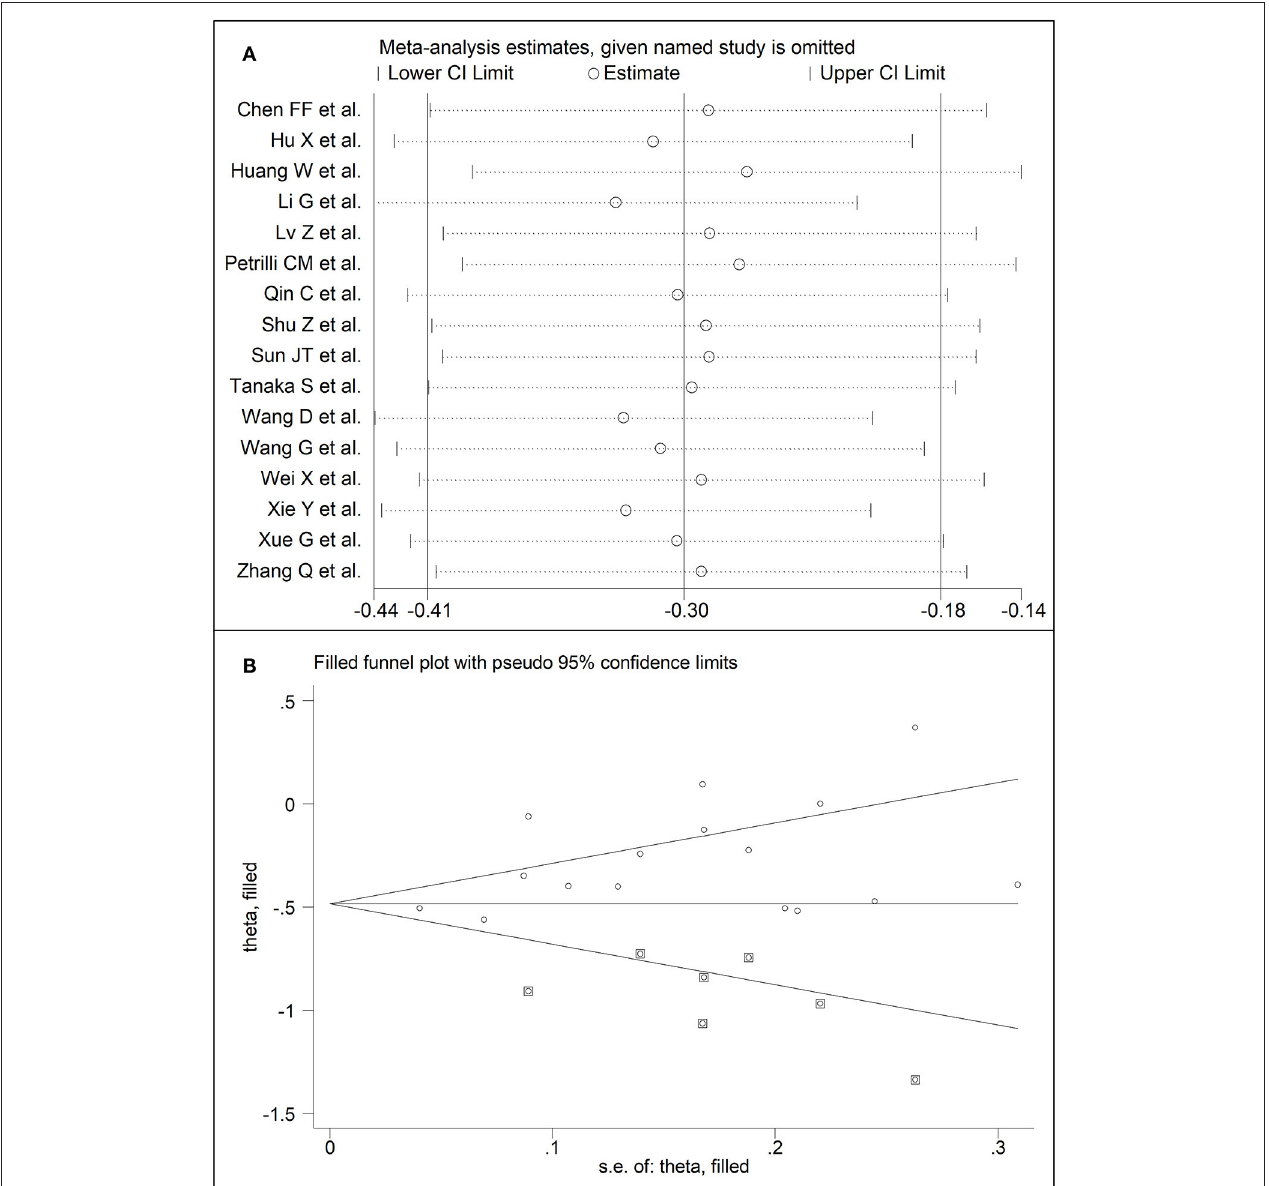
FIGURE 5 | (A) Sensitivity analysis of the association between LDL-cholesterol and COVID-19. The influence of individual studies on the overall standardized mean difference (SMD) is shown. The middle vertical axis indicates the overall SMD and the two vertical axes indicate the 95% confidence intervals (CIs). The hollow circles represent the pooled SMD when the remaining study is omitted from the meta-analysis. The two ends of each broken line represent the 95% CIs. (B) Funnel plot of studies investigating low vs. high severity or surviving vs. non-surviving status after trimming and filling. Dummy studies and genuine studies are represented by enclosed circles and free circles,